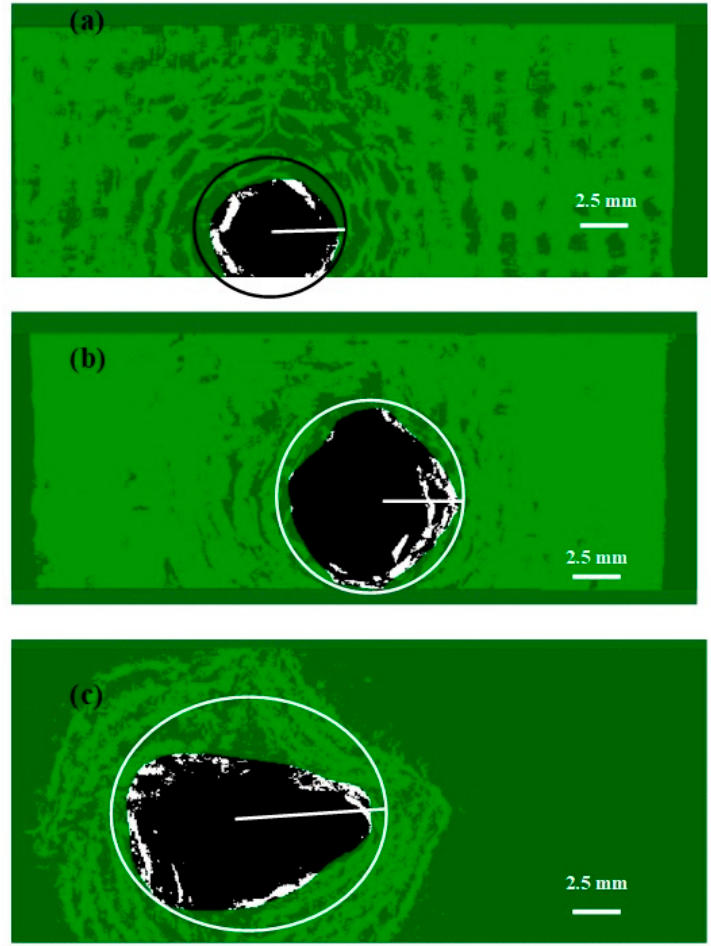
Figure 13. ( a ) The damage area of carbon, ( b ) E-glass, and ( c ) basalt reinforced composite. The green part represents the less affected area while the dark one represents the most affected